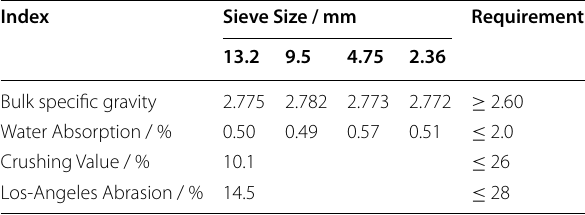
Table 1 Basic properties of coarse